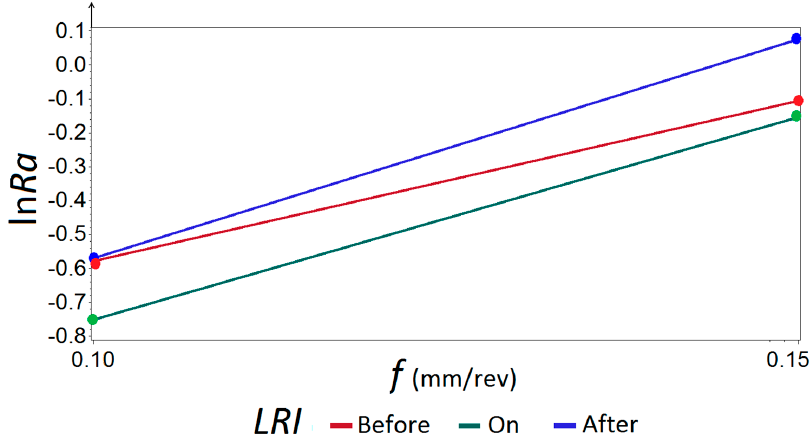
Figure 10. Interaction between the feed rate and location with respect to the insert for ln Ra.